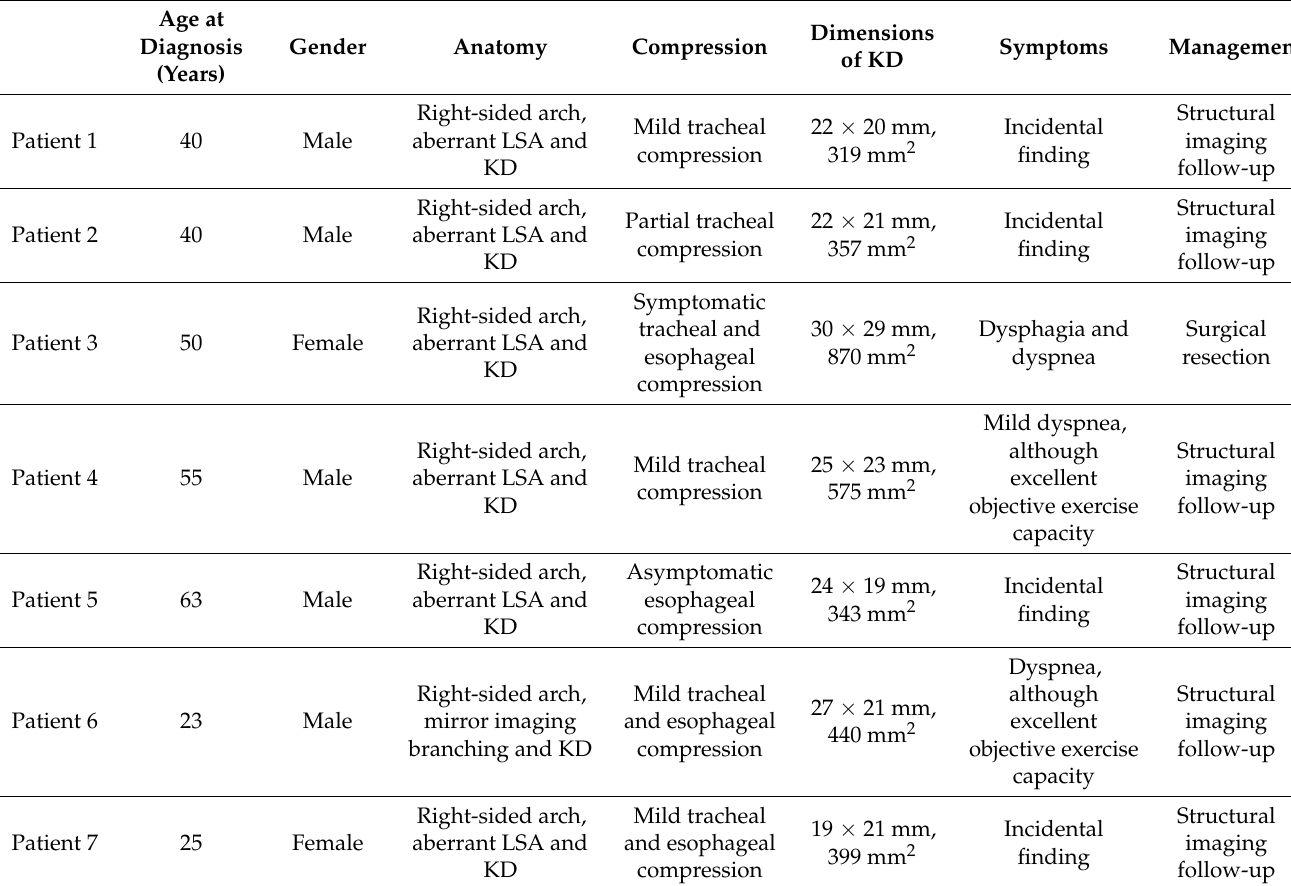
Table 1. An overview of the anatomical and clinical characteristics of patients